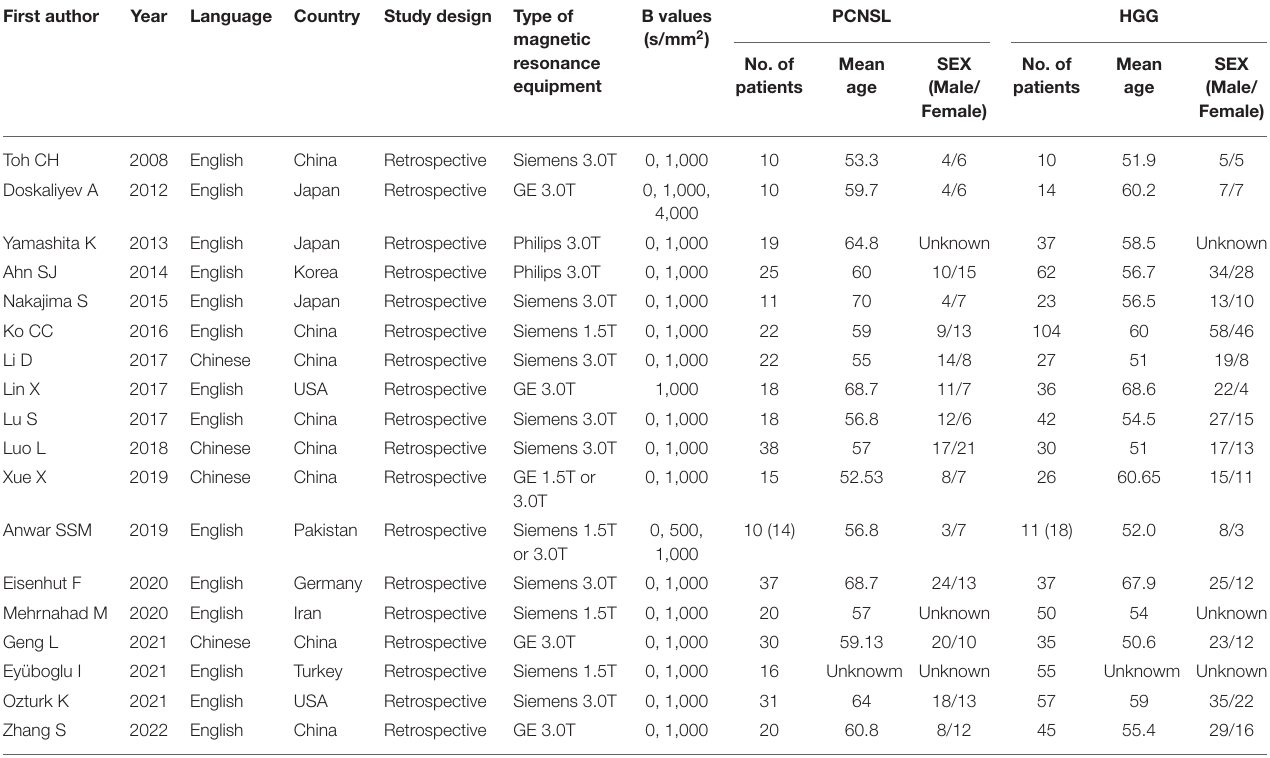
TABLE 1 | Basic clinical characteristics and parameters of the included literature.